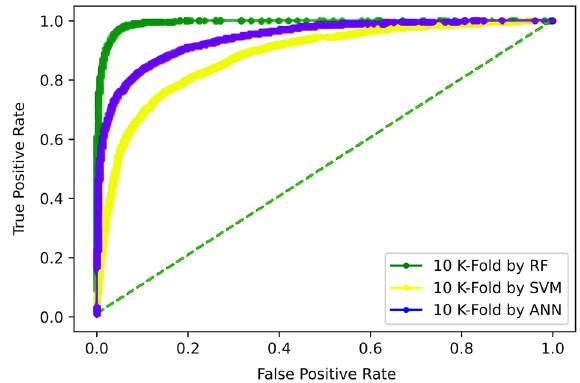
Figure 13. Tenfold cross-validation comparison of ROC.